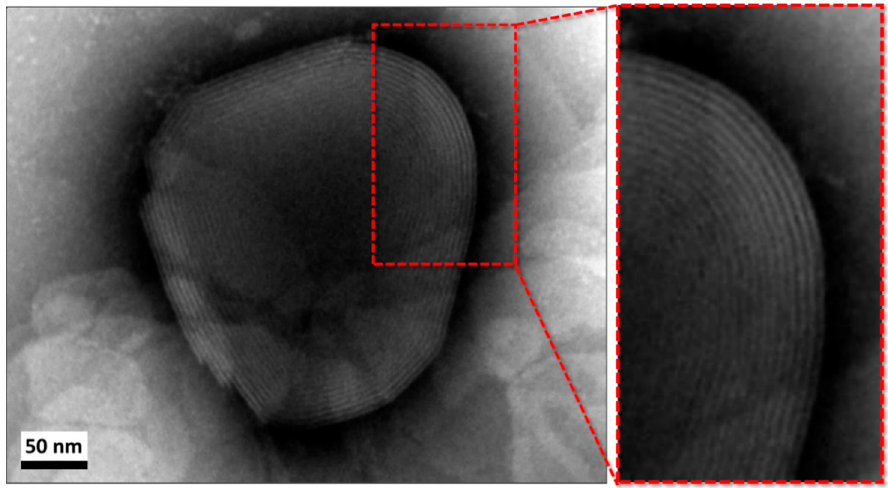
Figure 3. TEM images of the empty NVs. The inset highlights the obtained multilamellar structure.